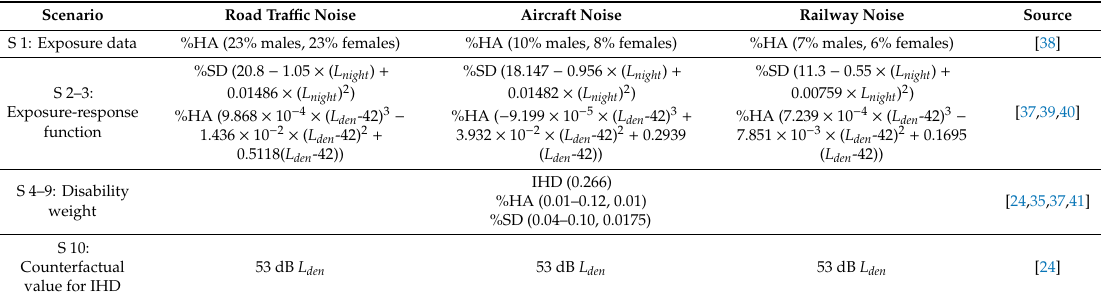
Table 5. Alternative input data used in the sensitivity